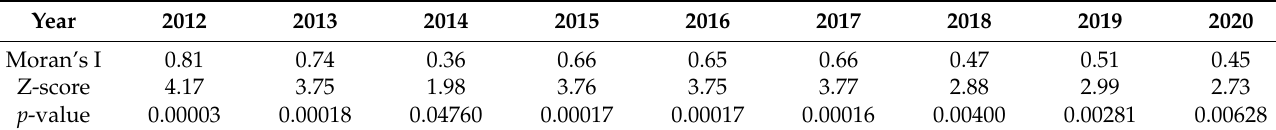
Table 2. The results of global spatial autocorrelation test.